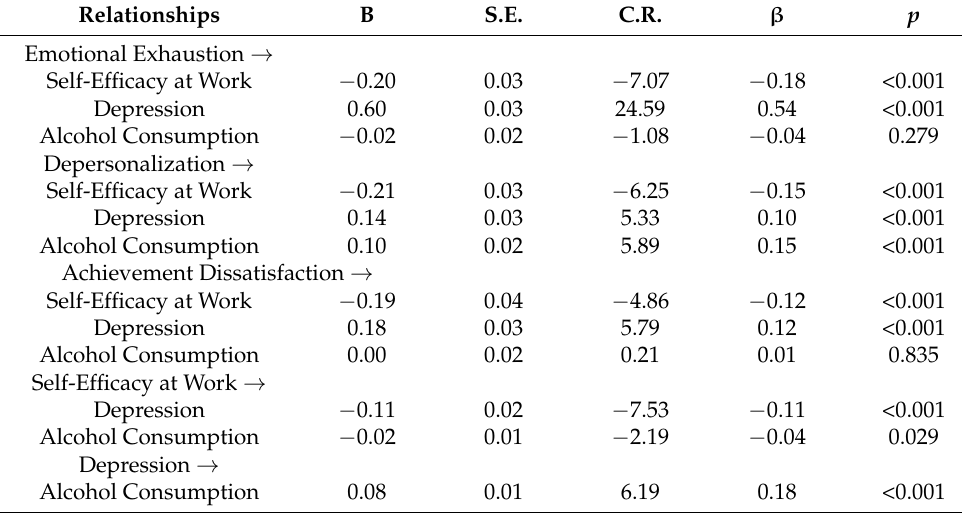
Table 1. Structural equation model of burnout predicting alcohol consumption. Relationships